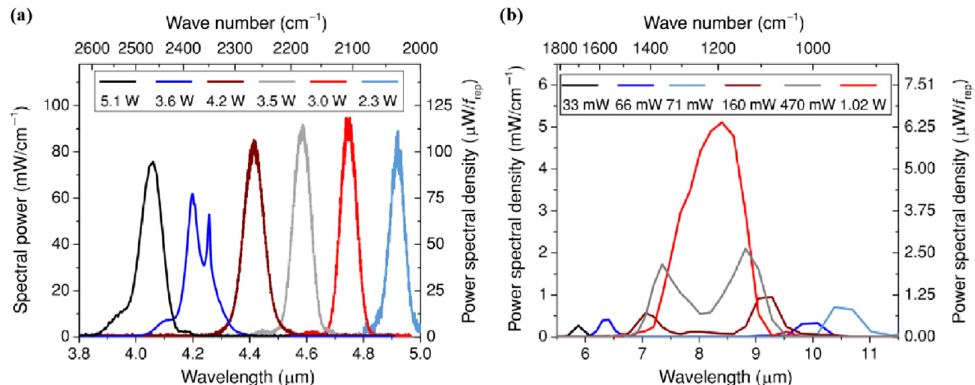
Figure 4. Tuning curves. ( a ) Generated MIR power for maximal pump power and tuning periods from 28 to 25.5 μ m of the PPLN. The spectrum centered at 4.2 μ m is shaped through CO 2 absorption. The power was measured 25 cm behind the nonlinear crystal. ( b ) Tuning curve measured with a type I phase-matched LGS crystal. The OPA operated the most powerfully around 8.2 μ m (slightly blue-shifted from type II). Upon detuning from this central point, the phase-matched wavelengths split, allowing the generation of very broadband spectra (vine red line). The spectra below 6 μ m (black line) and above 10 µ m (light blue line) needed different delays to be generated because of the uncompressed seed pulse. With type I phase matching, a maximal MIR power of 1.0 W could be generated. Type I, however, allowed the generation of slightly more broadband spectra than type II. Power spectral density is provided in units of mW/cm − 1 and µ W/f rep , where f rep = 37.5 MHz is the oscillator repetition rate. Reprinted with permission from